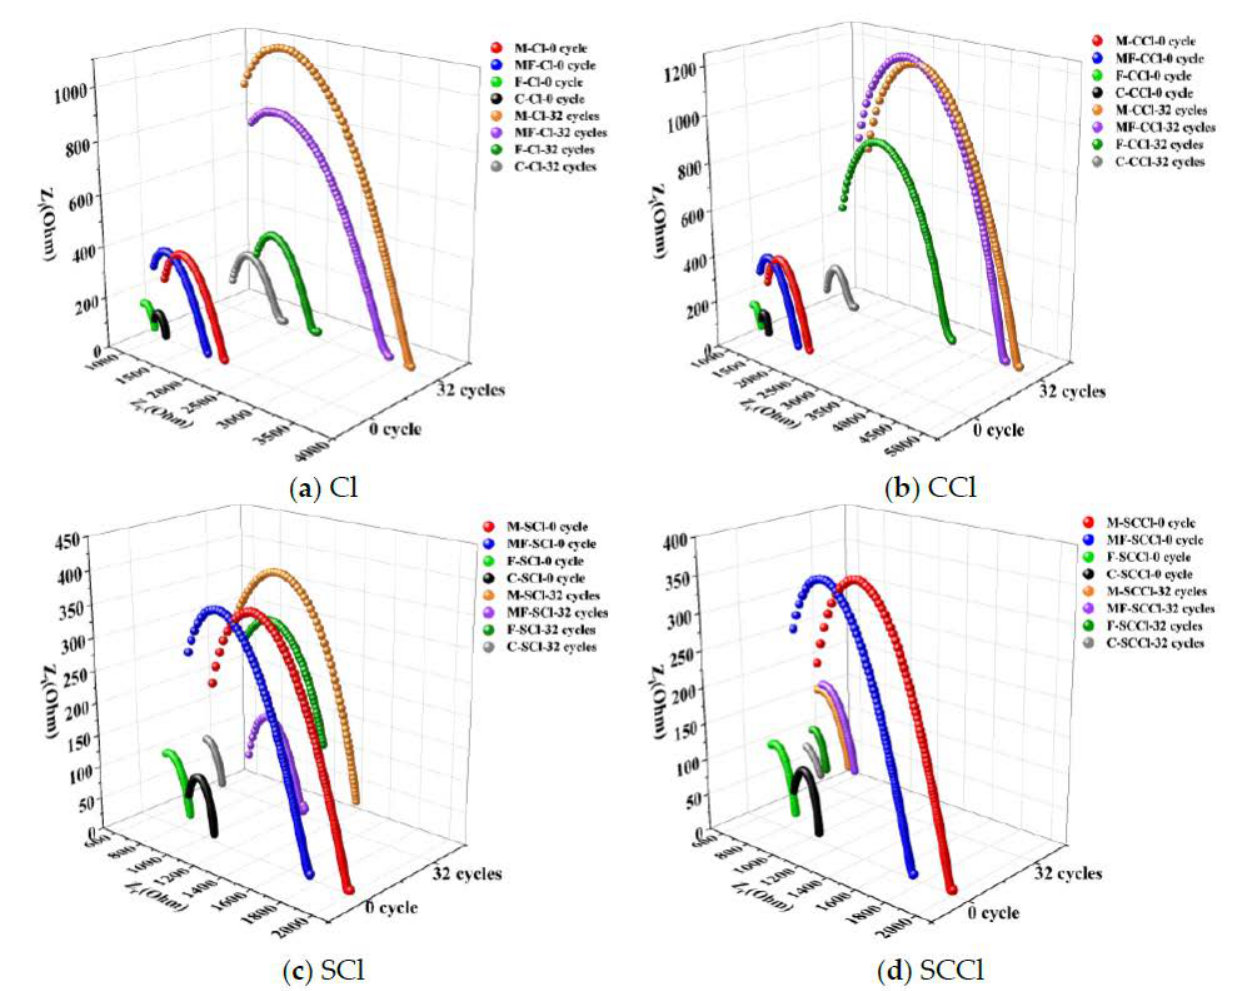
Figure 13. Nyquist plots of the specimens under different erosion